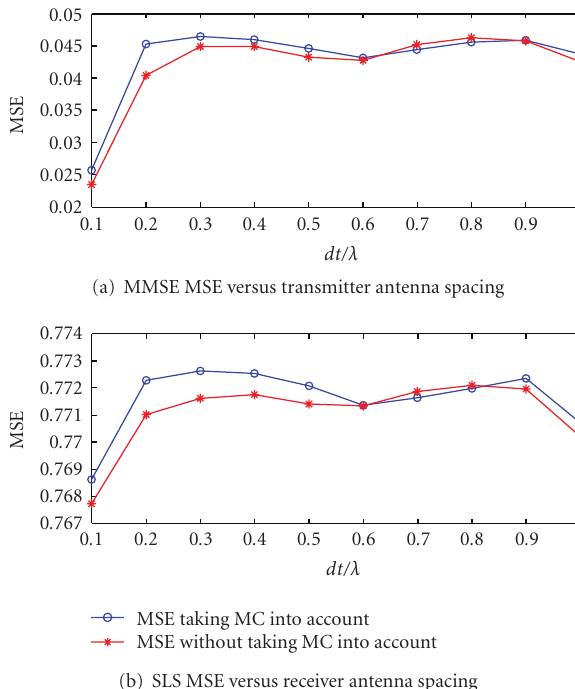
Figure 2: MSE of training-based channel estimation for a 4 × 4 MIMO considering mutual coupling e ff ect versus transmitter or receiver antenna spacing at SNR equal to 25dB. (a) MMSE MSE versus transmitter antenna spacing, receiver antenna spacing is set to 1 λ . (b) SLS MSE versus transmitter antenna spacing, receiver antenna spacing is set to 1 λ .